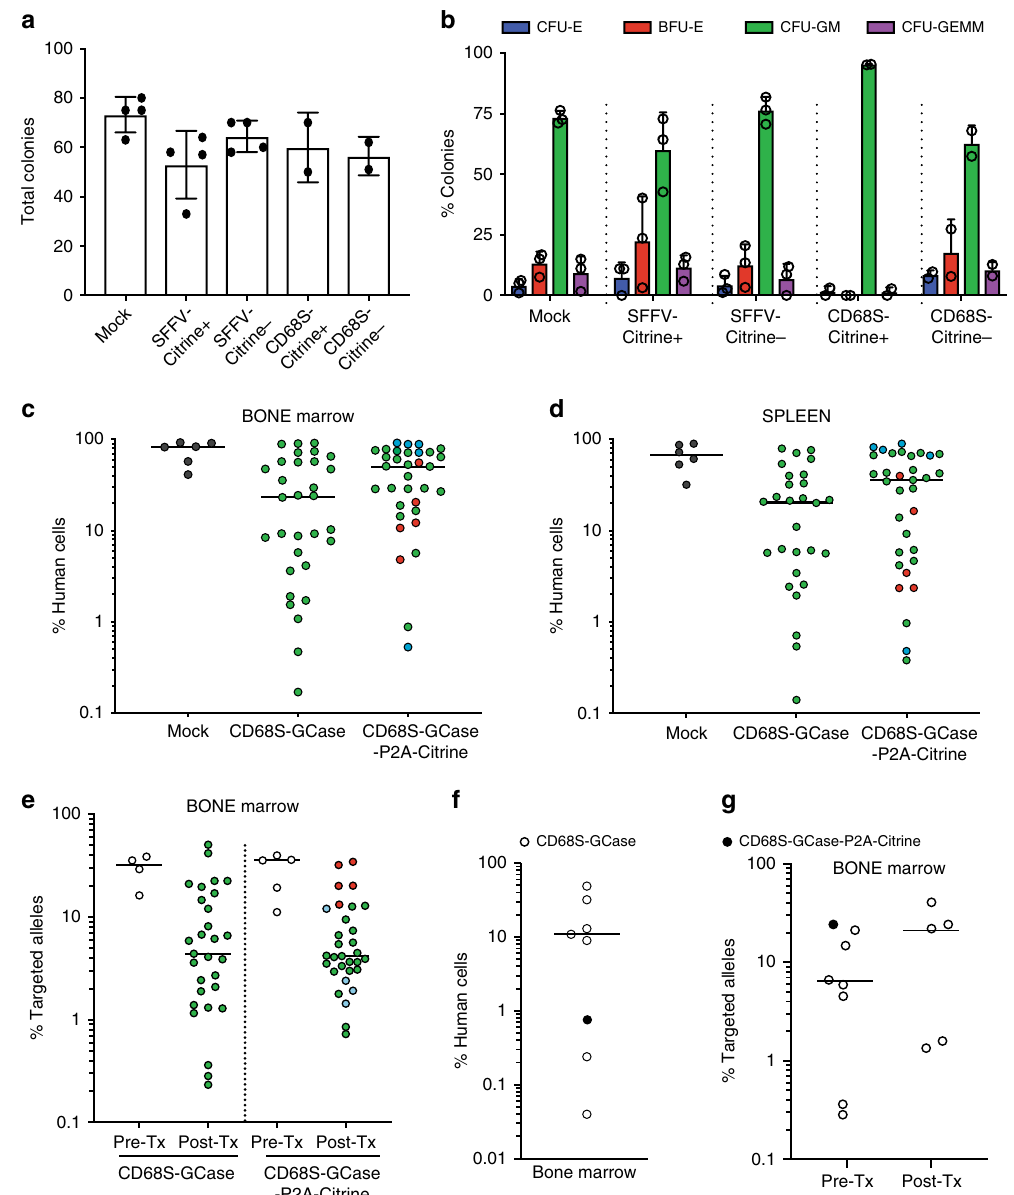
Fig. 4 GCase-targeted HSPCs sustain long-term hematopoiesis. a Total number of colonies formed from mock, Citrine + and Citrine – SFFV and CD68S- driven constructs ( n = 4 biologically independent human donor samples for Mock and SFFV and n = 2 for CD68S). b Distribution of phenotypes of colonies formed. Erythroid progenitors (burst-forming unit-erythroid or BFU-E (red)) and colony-forming unit-erythroid or CFU-E (blue), granulocyte-macrophage progenitors (CFU-GM, green), and multi-potential granulocyte, erythroid, macrophage, megakaryocyte progenitor cells (CFU-GEMM, purple) ( n = 4 biologically independent human donor samples for Mock and SFFV and n = 2 for CD68S). c Primary human engraftment (16 weeks) in the bone marrow in transplants using CD68S-GCase-targeted and CD68S-GCase-P2A-Citrine-targeted cells (blue circles: 0.25E6, green: 1E6, and red: 2E6 cells transplanted; n = 31, 33 mice). d Primary human engraftment in the spleen. e Targeted allele frequency in CD68S-GCase- and CD68S-GCase-P2A-Citrine-targeted cells before transplantation (Pre-Tx) and 16-weeks post-transplantation (Post-Tx) in engrafted human cells in the bone marrow of mice with human chimerism >1% ( n = 29, 31 mice). f Secondary human engraftment (32 weeks) in the bone marrow ( n = 8, black: CD68S-GCase-P2A-Citrine, white: CD68S-GCase). Note, three mice have chimerism <1%. g Targeted allele frequency before (Pre-Tx) and after transplant (Post-Tx) in the bone marrow cells of secondary mice. a – b Data shown as mean ± SD. c – g Median shown. Source data are provided as a Source Data fi drop in modi fi ed engrafted cells relative to the pre-transplant and lung using an enzymatic method and peritoneal macrophages level (43%) was 2.7-fold in the bone marrow, consistent with but were obtained by analysis of peritoneal fl uid. We in the low range of studies in NSG mice (Fig. 4e). We observed B, found robust human cell populations that were CD45 + or myeloid, and monocyte development with less preponderance of CD45/CD11b + as well as Citrine + in these macrophage cell B-lymphoid population compared to NSG mice. As before, preparations (Fig. 6d – f). Samples with high cell numbers that Citrine + cells were seen exclusively in the myeloid and monocyte allowed enrichment of live human-myeloid-Citrine + for enzy- cells (Fig. 6c). Tissue macrophages were extracted from liver matic analysis were sorted and the GCase activity measured.